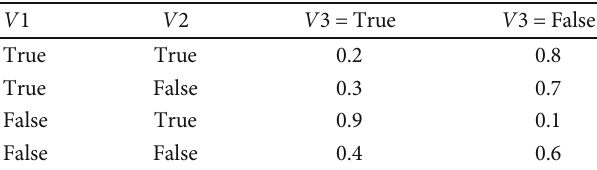
Table 3: Node 3 conditional probability